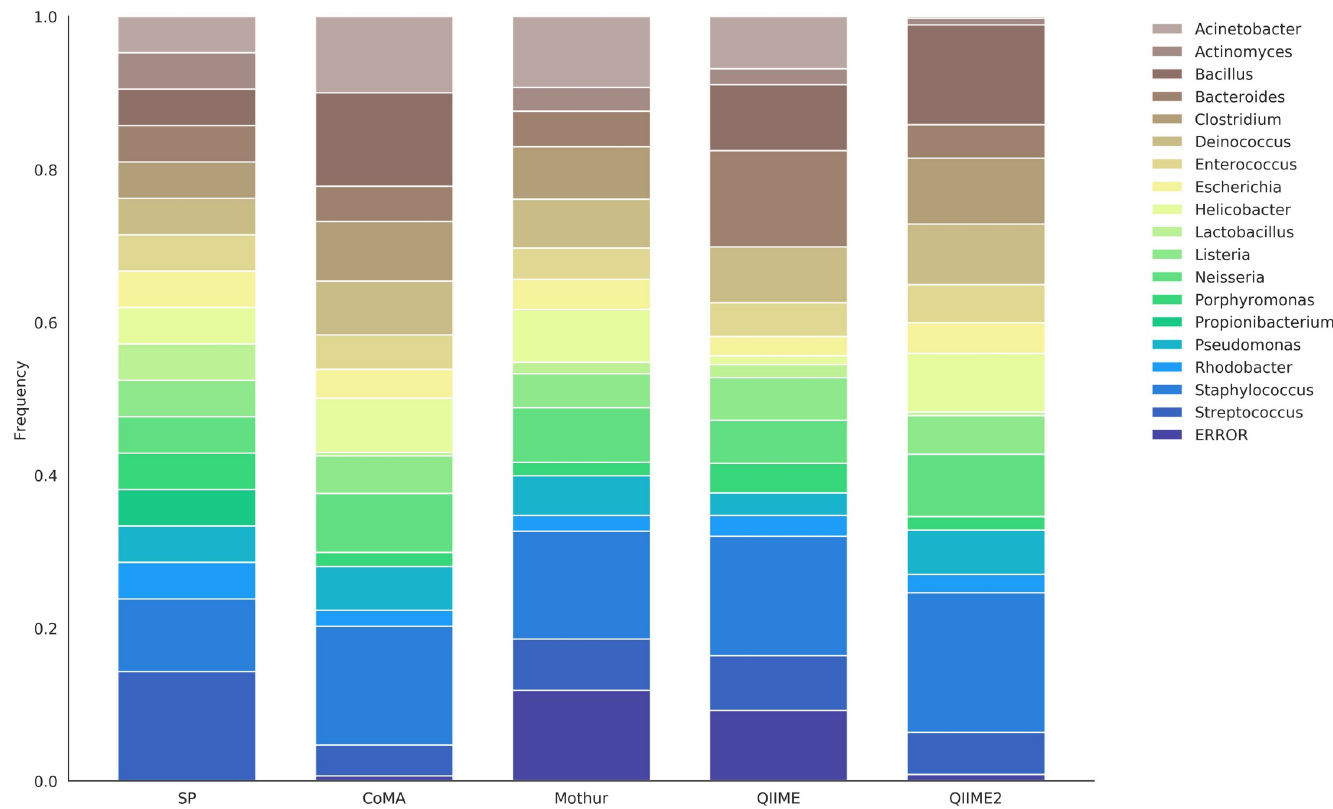
Fig 2. Community composition of the mock-13 dataset, revealed with four different analysis platforms. The set point (SP) depicts the theoretically expected distribution and serves as reference. The dataset comprised 18 bacterial genera, targeted with 16S rRNA amplicon sequencing.